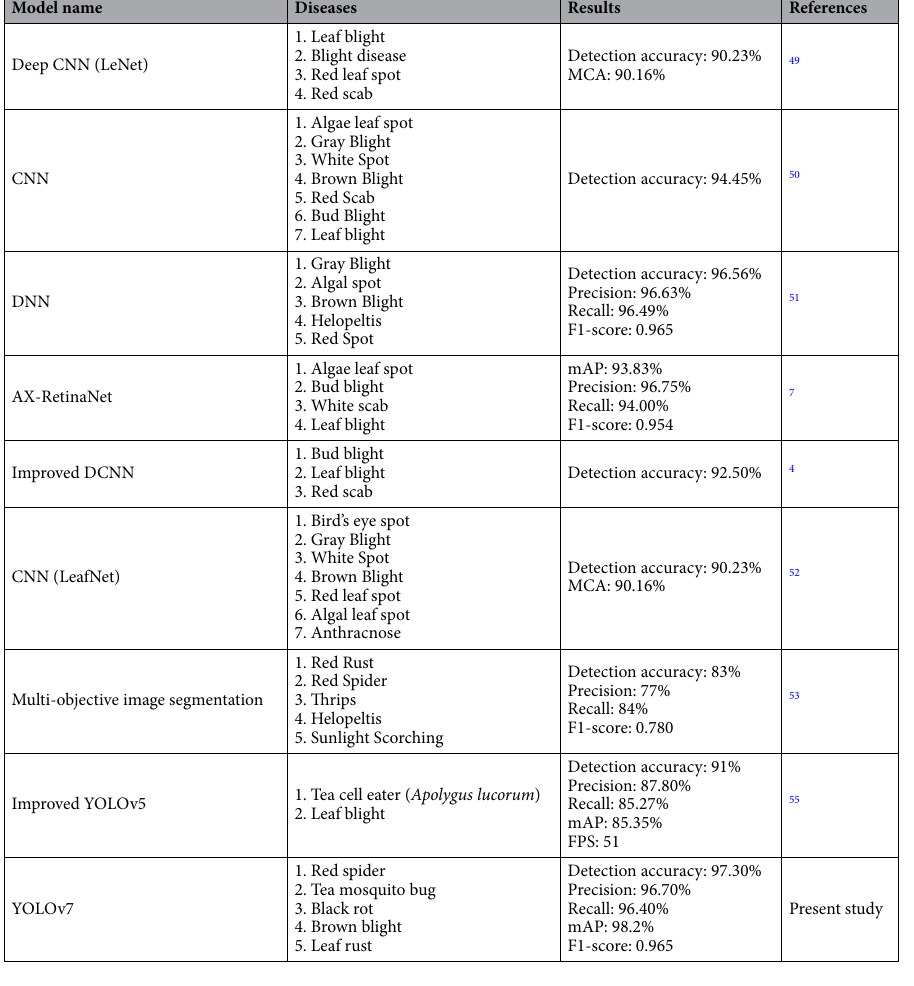
Table 3. Comparison of the outcomes of different tea leaf disease detection